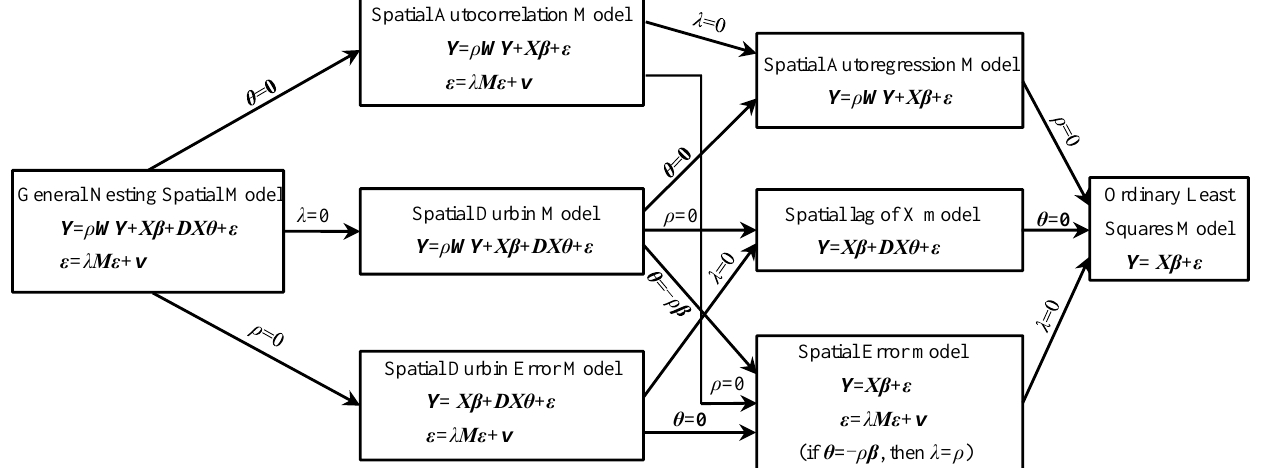
Figure 1. Relationship of various spatial econometric models.